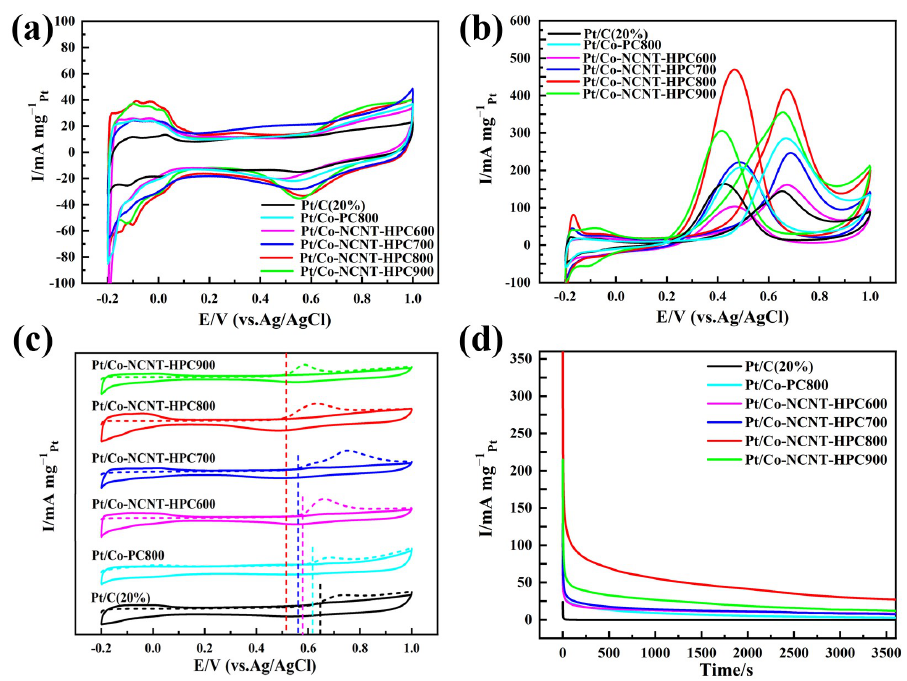
Figure 9. Electrochemical analysis data of ( a ) CV curves in 0.5 mol L − 1 H 2 SO 4 solution at a scan rate of 50 mV S − 1 ; ( b ) CV curves in 0.5 mol L − 1 H 2 SO 4 and 0.5 mol L − 1 CH 3 OH solution at a scan rate of 50 mV S − 1 ; ( c ) CO-stripping curves in 0.5 mol L − 1 H 2 SO 4 solution; and ( d ) Amperometric i–t curves in 0.5 mol L − 1 H 2 SO 4 and 0.5 mol L − 1 CH 3 OH solution for 3600 s of Pt/C (20%), Pt/Co-PC800,